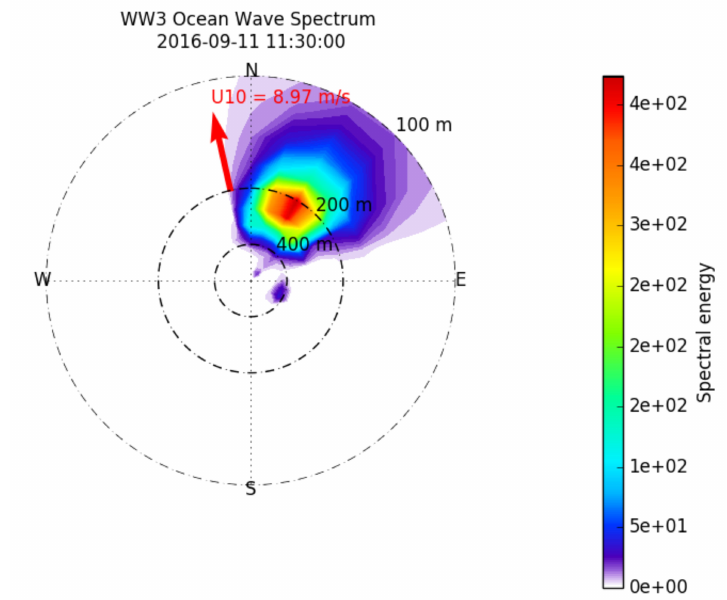
Figure 8. WW3 hindcast ocean wave spectrum on 11 September 2016 at 11:30 (UTC) at 23.0 ◦ S/91.0 ◦